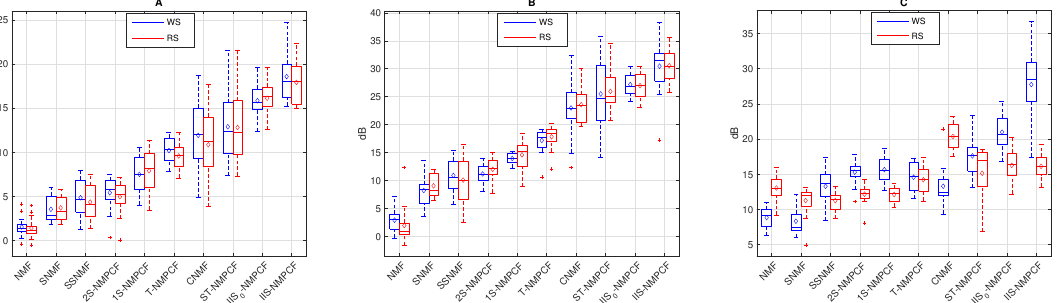
Figure 7. SDR w and SDR r results ( A ), SIR w and SIR r results ( B ) and SAR w and SAR r results ( C ) evaluating the dataset T1H (SNR = 5 dB). Note that SDR w , SIR w and SAR w are represented by blue boxes while SDR r , SIR r and SAR r are represented by red boxes.